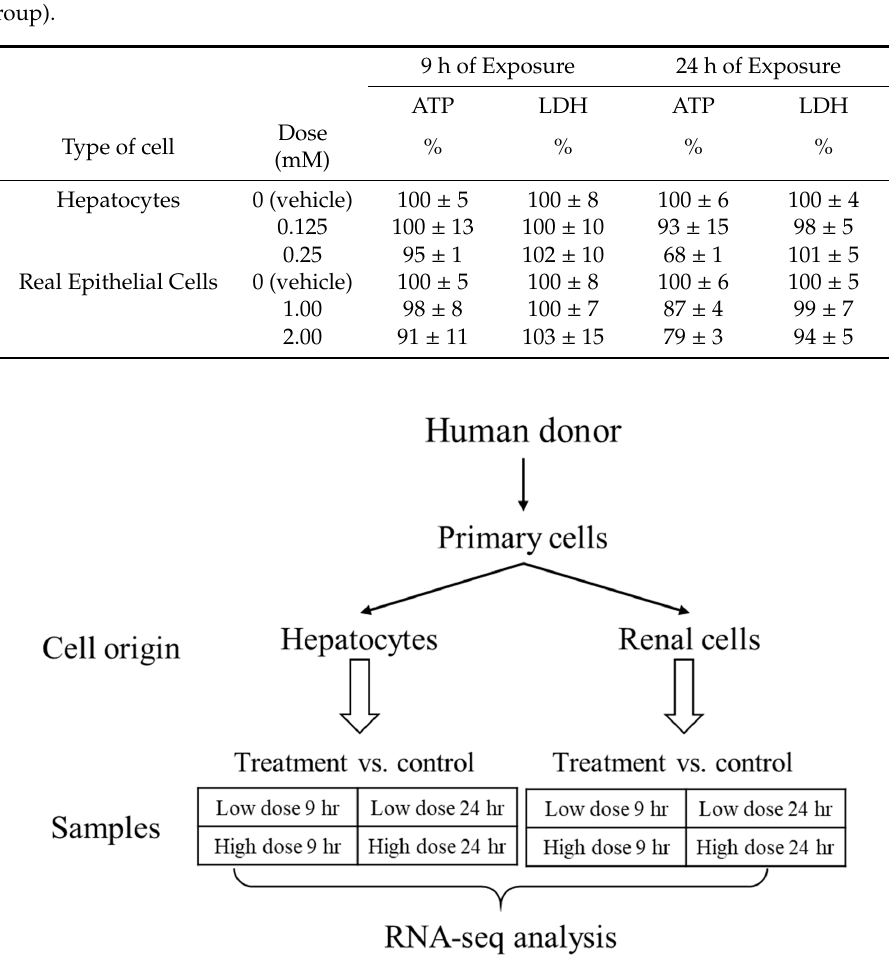
Figure 7. Data collection design for generating human in vitro gene expression signals from liver and kidney derived kidney derived tissues.